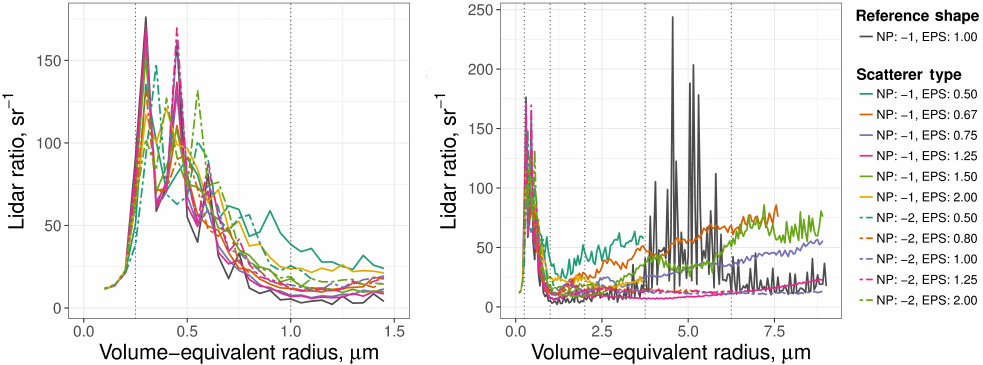
Figure 9. The same as Fig. 7 but for the pure lidar ratio. Similar to the observations for the backscatter cross section (see Fig. 8), the particle shape sensitivity of the pure lidar ratio is negligible for particles smaller than 0 . 5 λ . For larger particles, the spherical shape tends to have the lowest pure lidar ratio value of all particle shapes (namely for a particle radius between 0.5 and 3.5µm). Peaks of the pure lidar ratio are observed for spheres with a radius between 4 and 6µm which are due to interference effects. Large ellipsoids tend to have the highest pure lidar ratio values in comparison with other particle shapes; large cylinders have an almost constant value of the pure lidar ratio of about